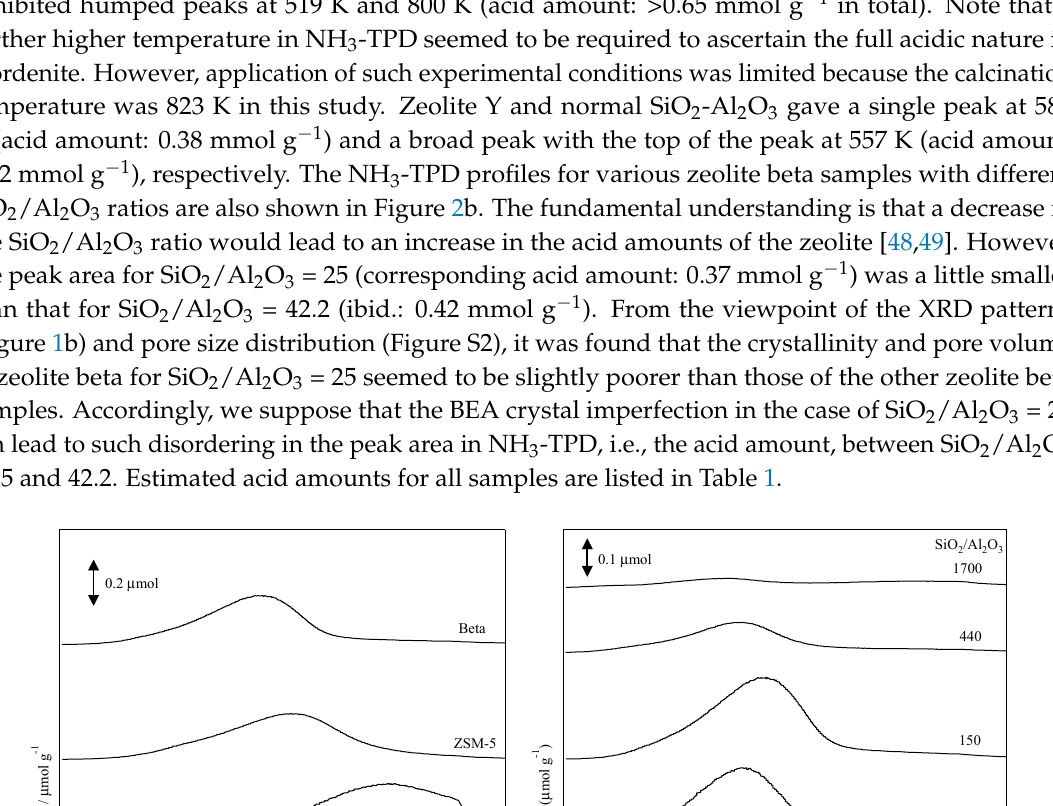
Figure 1. X-ray diffraction (XRD) patterns of ( a ) four types of reference zeolites and normal SiO 2 -Al 2 O 3 and ( b ) zeolite beta samples composed with various SiO 2 /Al 2 O 3 ratios.